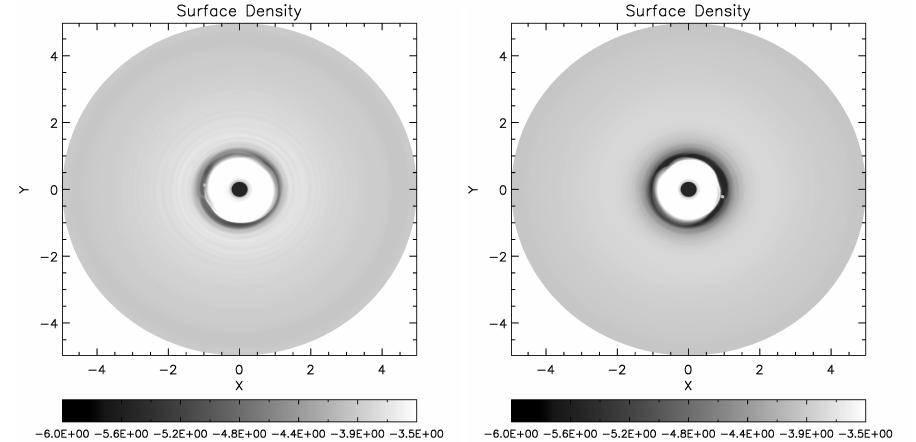
Fig. 2. The same as in Fig. 1b but for q = 0 : 01 with a softening length of 0 : 6 H after 100 (left panel ) and 800 orbits (right panel). As the mass ratio is lower in this case compared to that of Fig. 1b the gap in the disk is narrower. The companion, indicated by the small light-gray circle is found, in general, to orbit closer to the inner disk edge at earlier times. In the left-hand panel the companion grazes the inner edge slightly above the x axis for x < 0 : This enhances the accretion rate at that